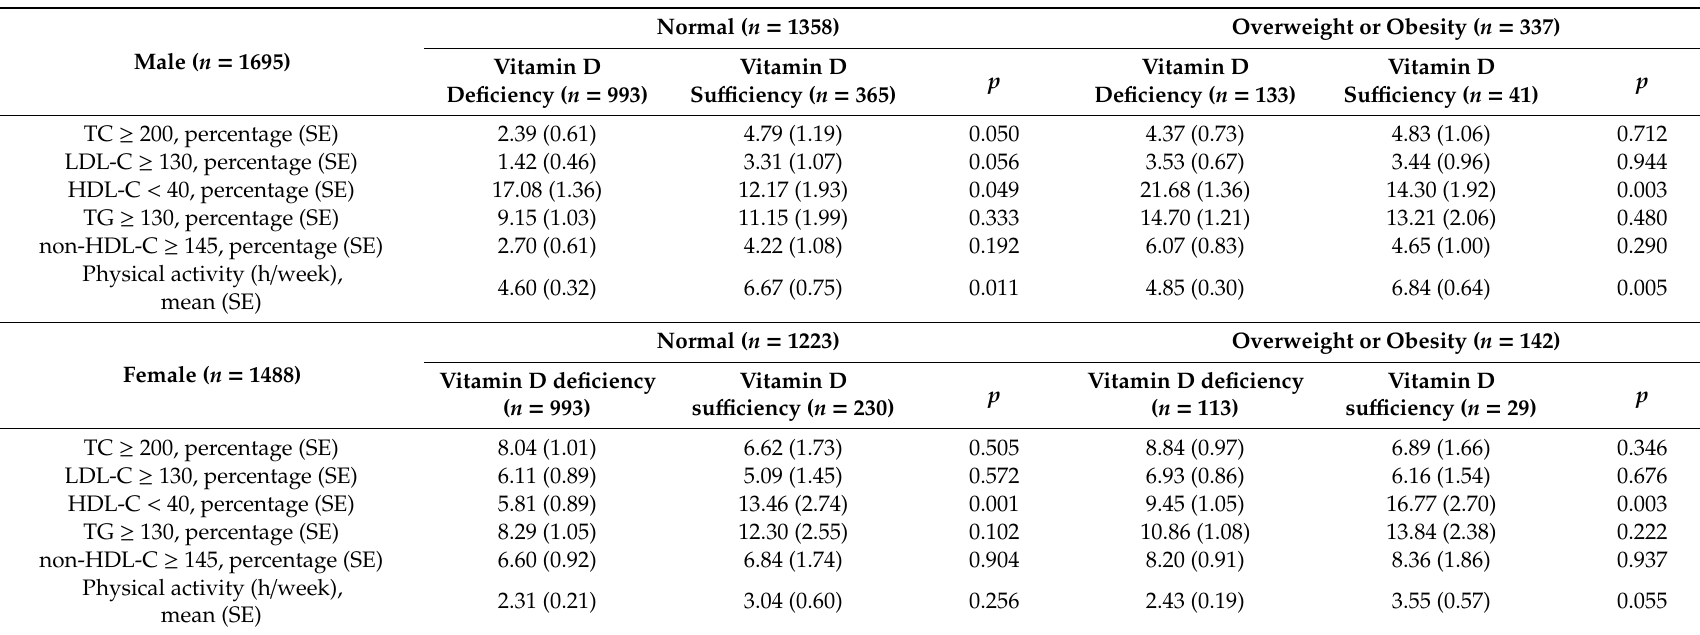
Table 2. Proportion of subjects with dyslipidemia and physical activity among the youth according to sex, BMI, and 25OHD